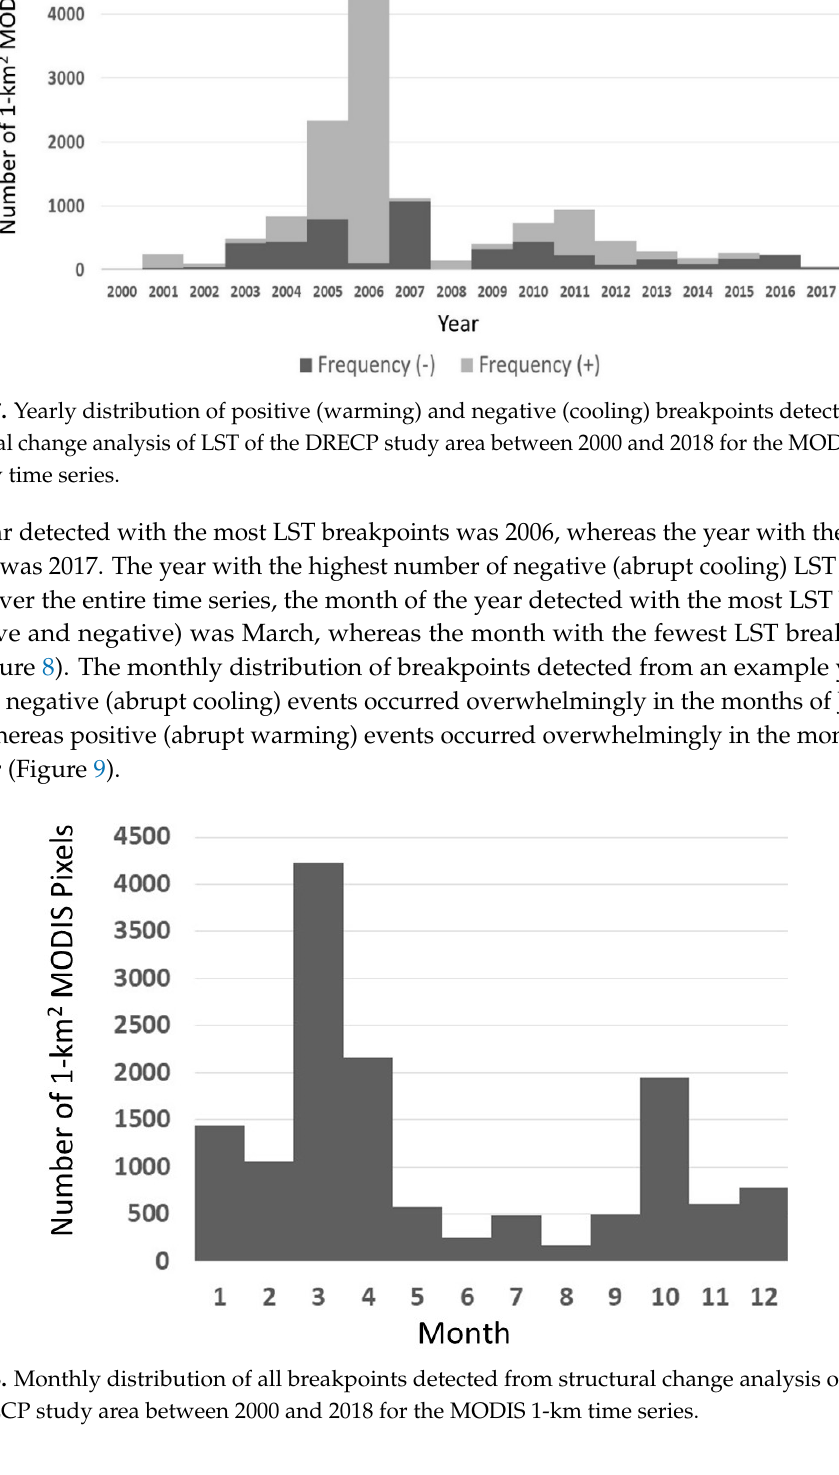
Figure 6. Map of breakpoints detected from structural change analysis of LST between 2000 and 2018 for MODIS 1-km monthly time series. All Monitoring Trends in Burn Severity (MTBS) wildfire boundaries since the year 2000 are shown as gray outlines. Number of breakpoints per pixel shown in the color legend (upper right).